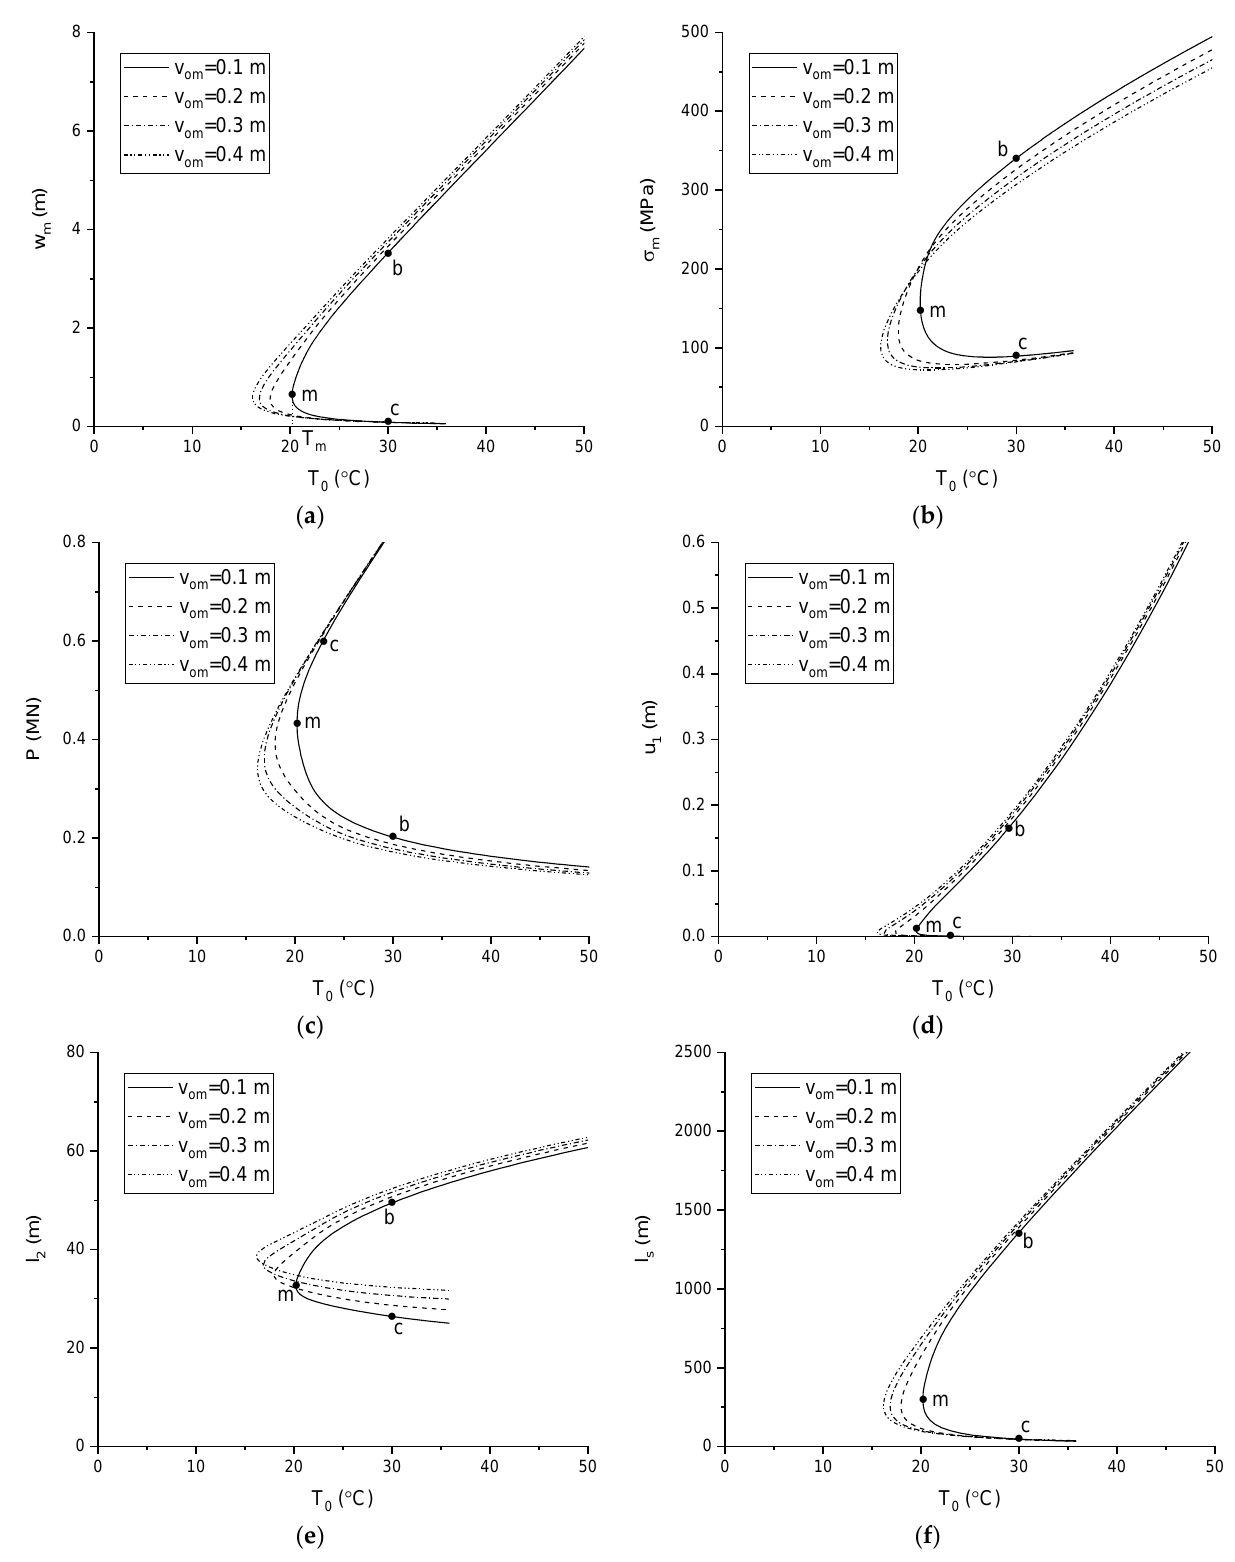
Figure 11. Influence of 𝑣 𝑜𝑚 on the buckling behaviour. ( a ) 𝑤 𝑚 . ( b ) 𝜎 𝑚 . ( c ) 𝑃 . ( d ) 𝑢 1 . ( e ) 𝑙 2 . ( f ) 𝑙 𝑠 ( 𝜇 𝑏𝑟𝑘 = 2.0 , 𝜇 𝑠 = 0.1 ).